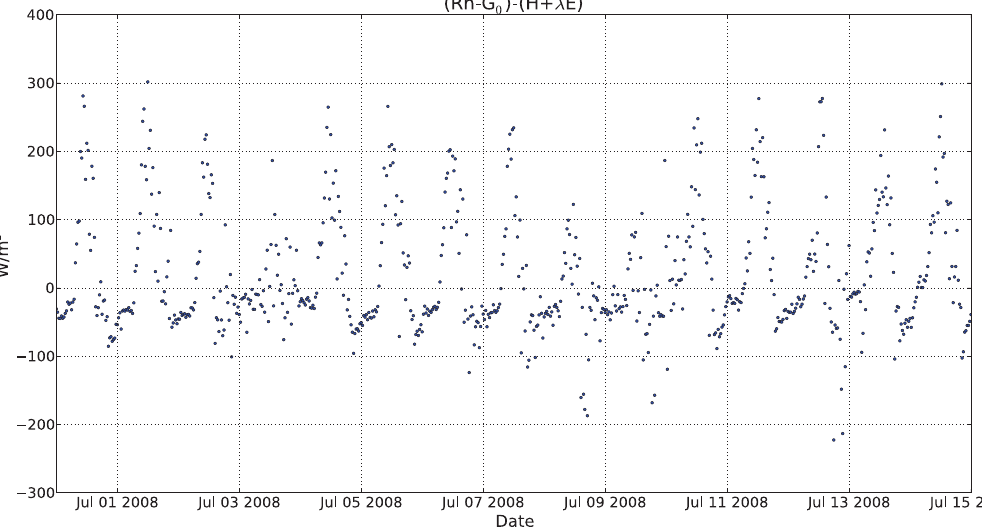
Figure 8. Time-series of energy balance deficit from the 30 June to the 14 July 2008 at the Yingke